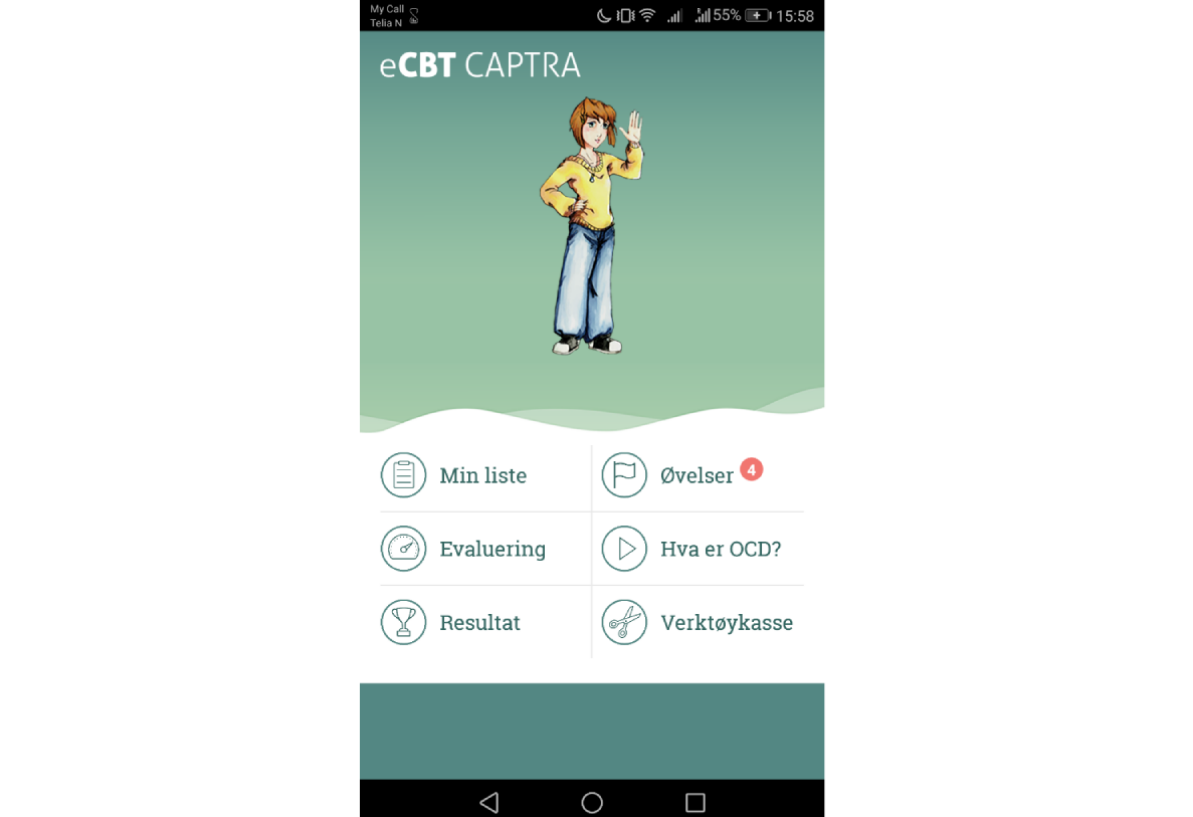
Figure 2. Screenshot of the app for